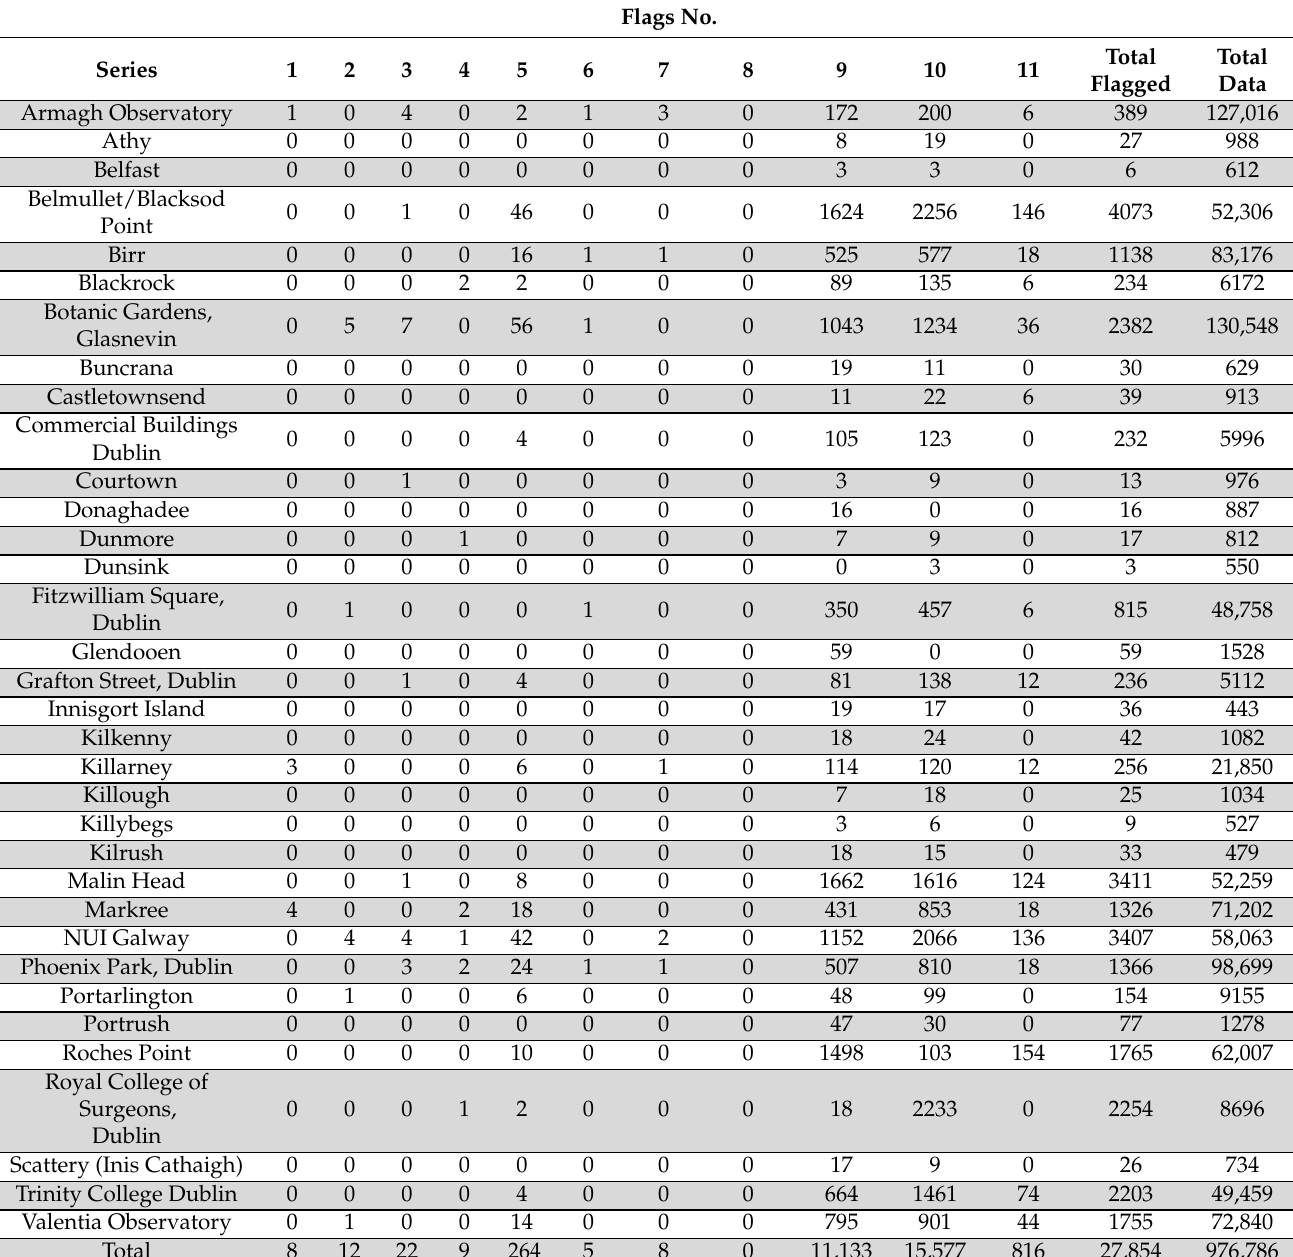
Table 6. Geographical distribution of flags. Flags